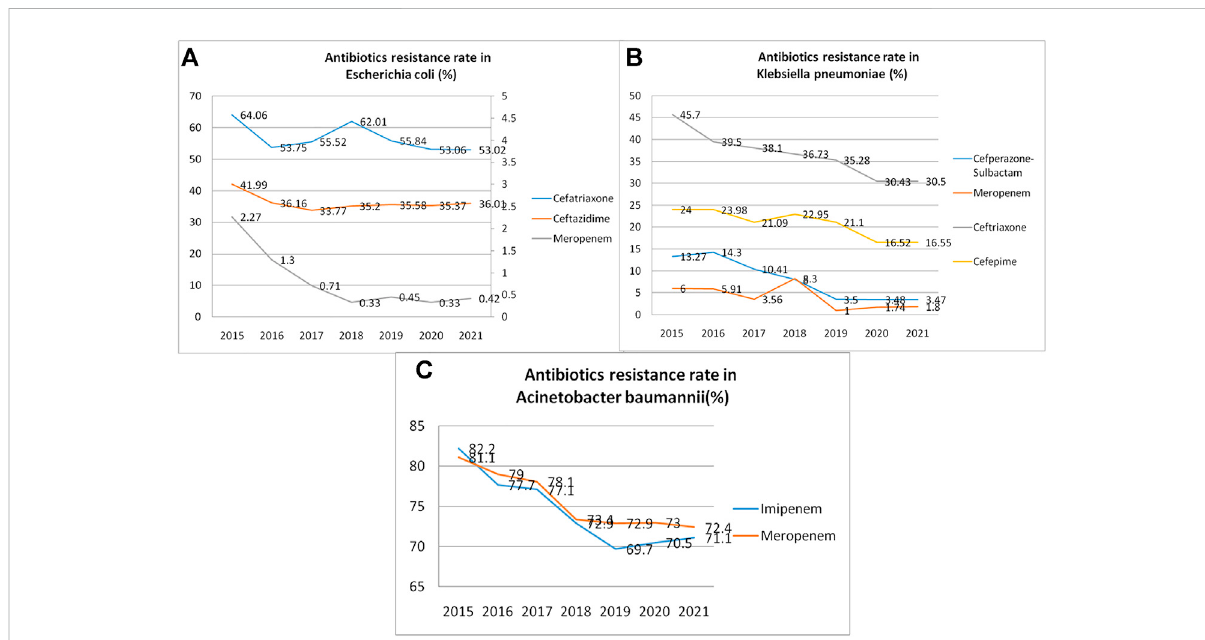
FIGURE 3 Antibiotic resistance rates (per year) reduced remarkably during the study period. (A) . Resistance rate of three antibiotics commonly used in Escherichia coli infection ; (B) . Resistance rate of four antibiotics commonly used in Klebsiella pneumonia infection ; (C) . Resistance rates of two antibiotics commonly used in Acinetobacter baumannii